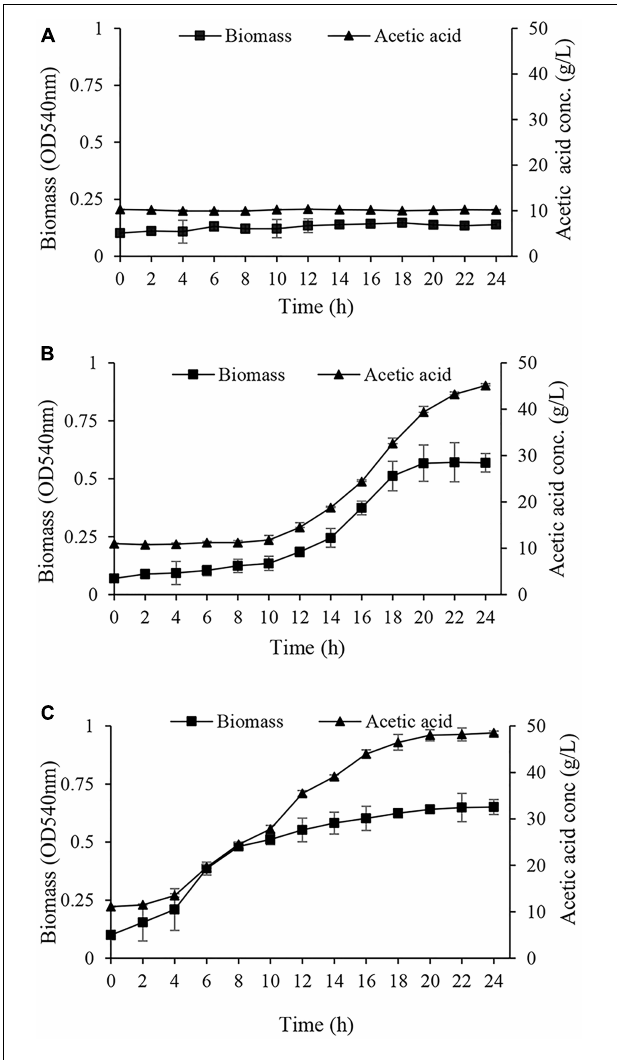
FIGURE 3 | Growth and acetic acid production of Acetobacter senegalensis LMG 23690 T acclimated to different carbon sources. Acclimated cells were harvested and washed, then they were inoculated into GYEA broth containing 5% (w/v) ethanol and 1% (w/v) acetic acid. Results are representative of three independent experiments and are expressed as mean ± SD (error bars) of three replicates. (A) Cells acclimated to EtOH condition did not grow during 24 h. (B) Cells acclimated to glucose (Glc condition) started to grow after a long (10 h) lag phase. (C) Cells acclimated to a mixture of glucose and acetic acid (GlcAA condition) resumed the growth after a very short lag